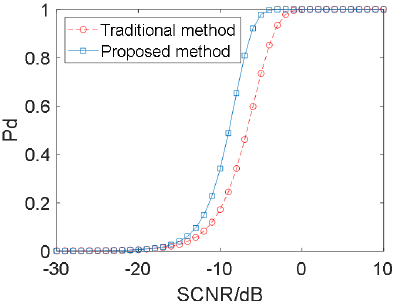
Figure 21. Graph of SCNR and detection